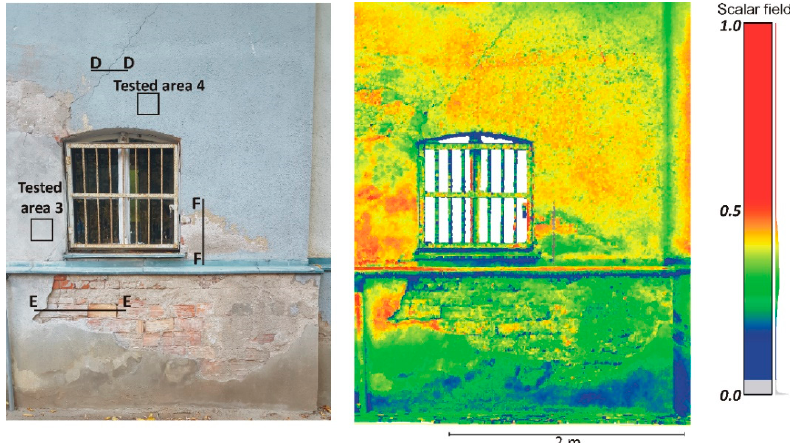
Figure 2. Part of the citadel brick wall—real photo on the left, point cloud on the right.